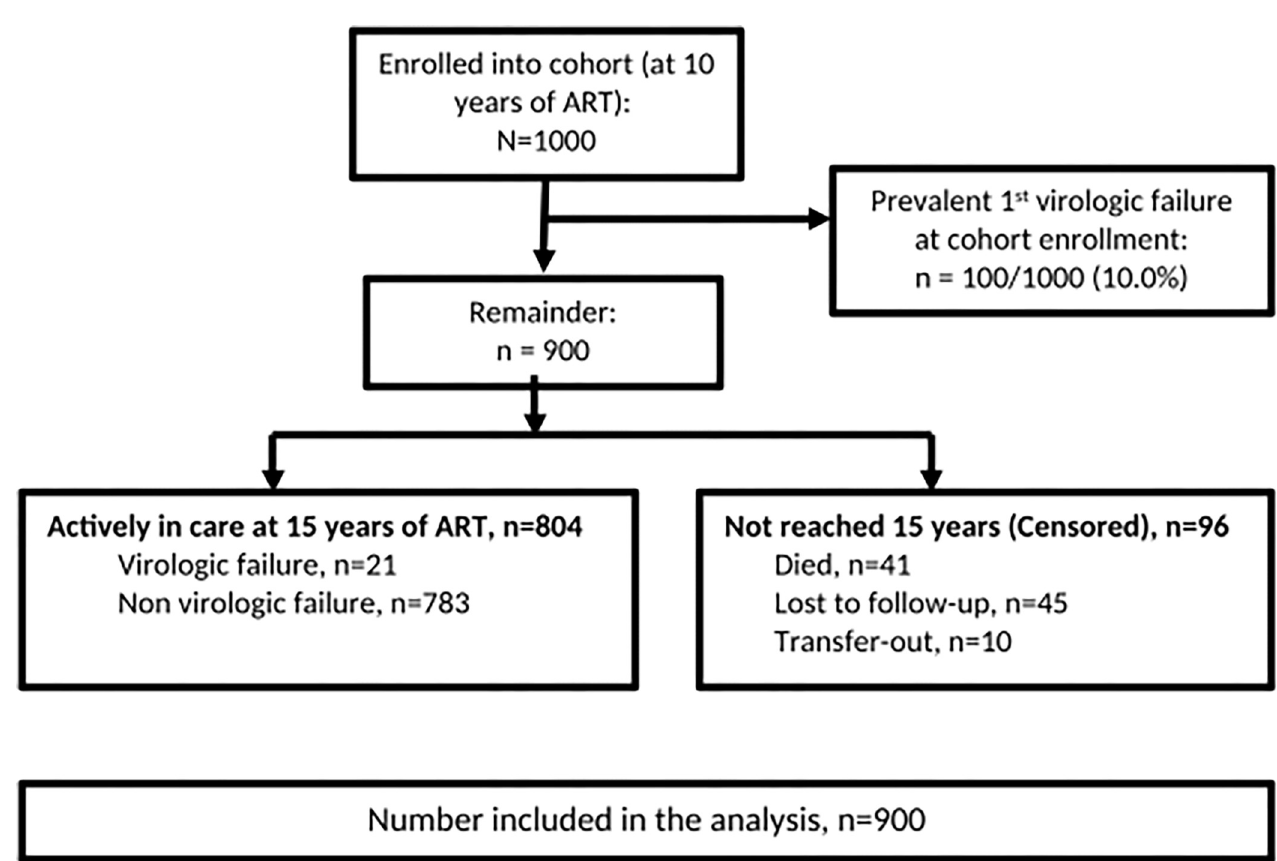
Fig 1. Cohort data flow diagram. Description of study participants